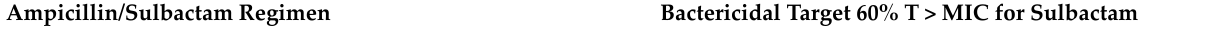
Table 3. Pulmonary PK/PD breakpoints of ampicillin/sulbactam for A. baumannii treatment with sulbactam